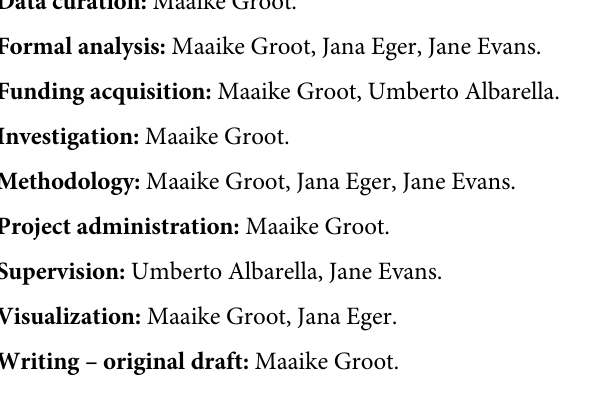
S1 Table. Context information on the specimens used in this study. S2 Table. Intra-tooth oxygen and carbon isotope ratios of enamel from cattle teeth from Houten-Castellum. Wear stages after Grant (1982)